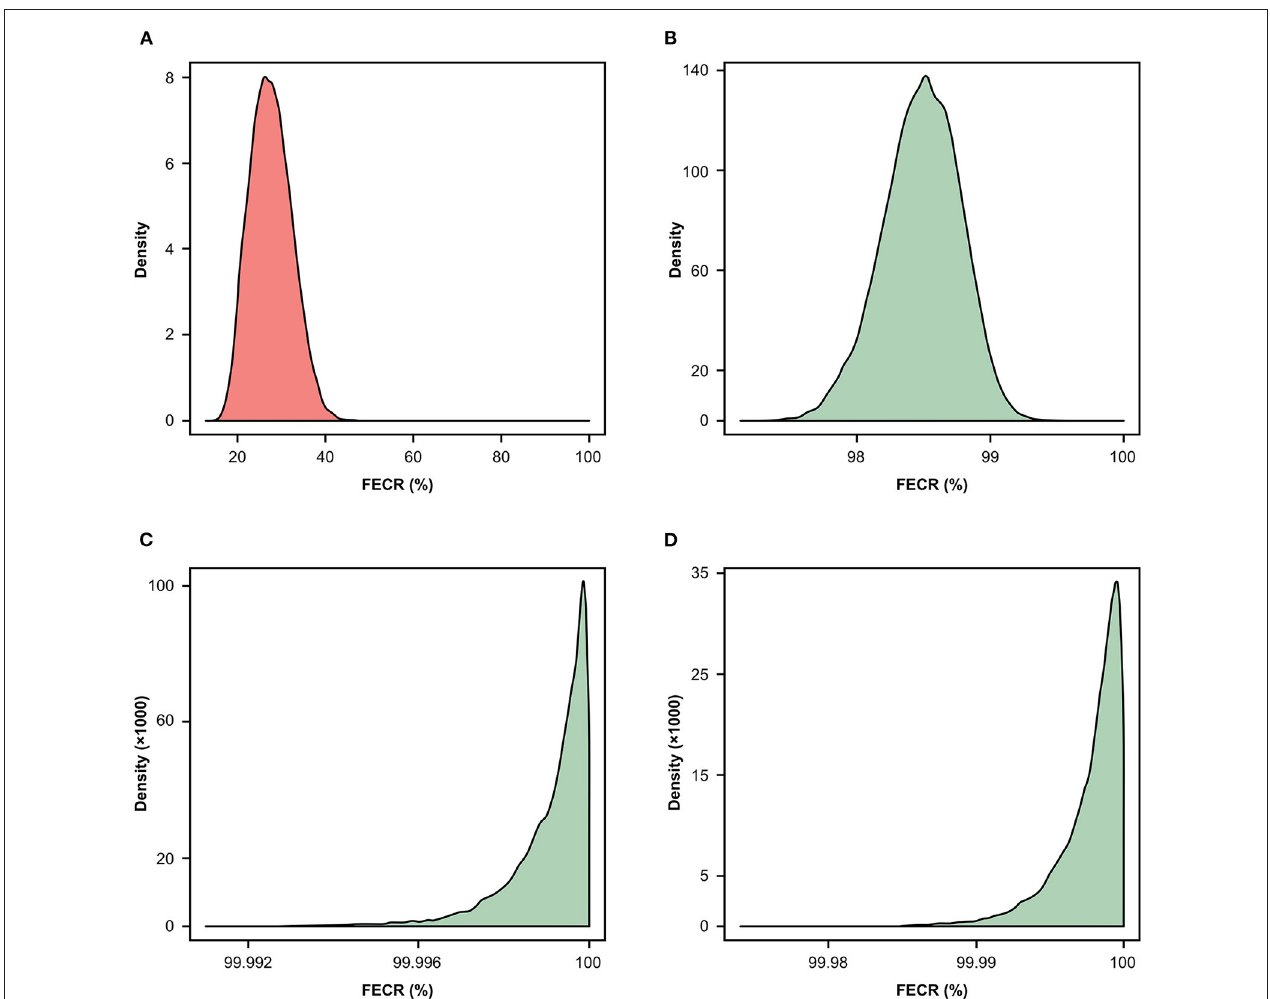
FIGURE 4 | Posterior probability distribution of FECR% for FBZ (A) , PYR (B) , IVM (C) and MOX (D) at the horse level. FBZ, fenbendazole; FECR%, fecal egg count reduction; IVM, ivermectin; MOX, moxidectin; PYR, pyrantel